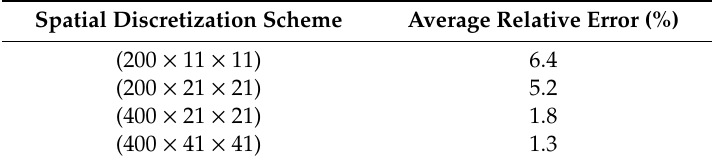
Table 5. Spatial discretization e ff ects on the average relative error (using the FT8 on angular